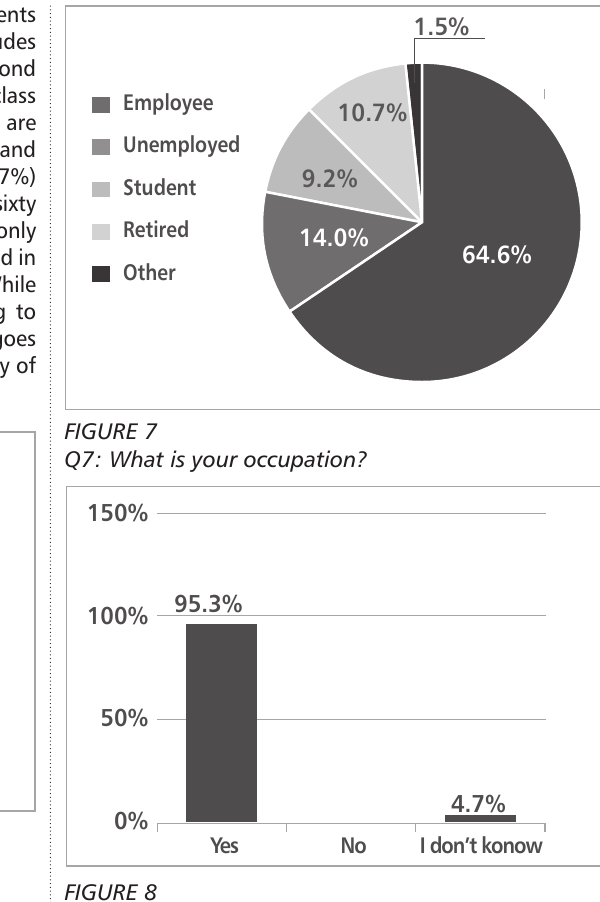
Q8:Are you familiar with the term urban